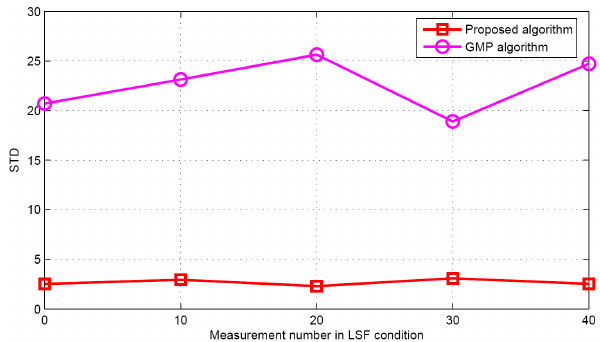
Figure 16. The STD of the estimated population in LSF conditions.